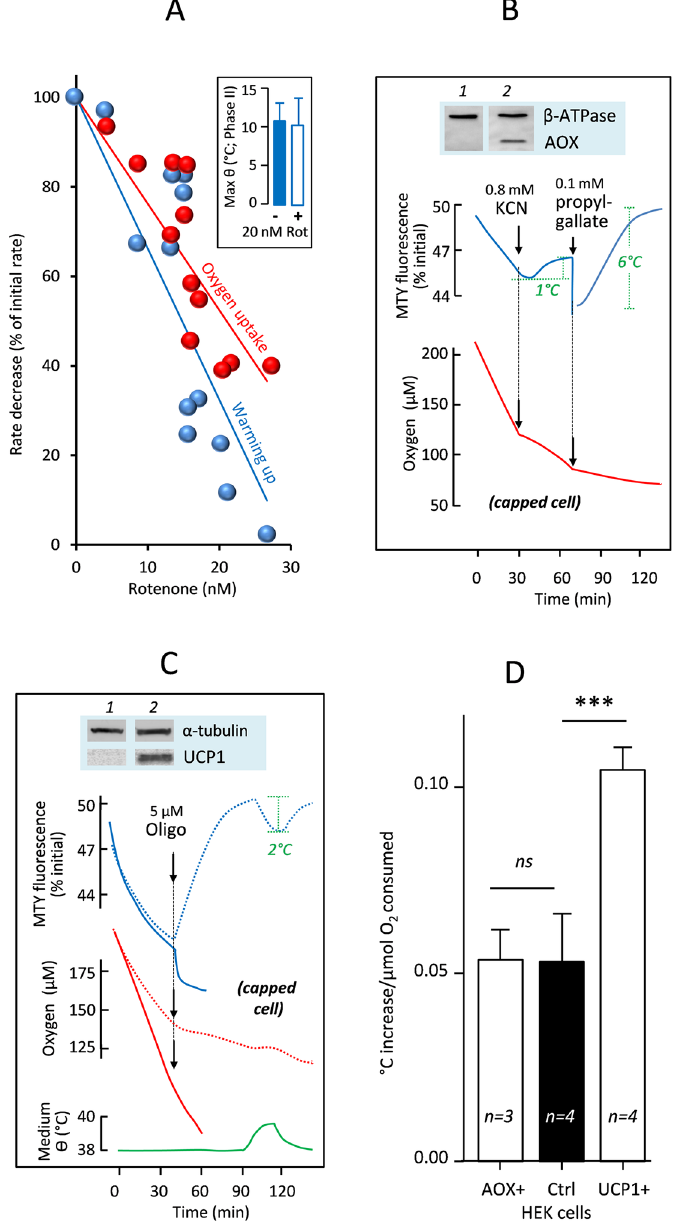
Fig 3. Effects on mitochondrial temperature of respiratory inhibitors, uncouplers, and expression of heterologous mitochondrial proteins. (A) Effect of variable rotenone addition to control HEK293 cells on the rates of oxygen uptake and fluorescence decrease of MTY. Rotenone was added at t = 4 min; rates calculated from 4–7 min and expressed as a percent of initial rate. Inset: maximal warming of HEK293 cell mitochondria in the absence or presence of 20 μM rotenone. (B, C) Changes in MTY fluorescence (blue lines), cell respiration (B, C) (red lines), and temperature of cell suspension medium (green line), with additions of inhibitors as shown (potassium cyanide, n- propyl gallate, and/or oligomycin), alongside western blots confirming expression of the indicated genes: Ciona intestinalis AOX (B), UCP1 (C), alongside loading controls, as indicated. Traces for control cells are shown by dotted lines. The abrupt change in fluorescence upon addition of n-propyl gallate is due to the absorbance of the chemical itself. Note that in all experiments in which MTY fluorescence was measured, the value reached at the end of phase I was in all cases significantly different from the starting value, whilst that in phase IV was not ( n = 4; (cid:3)(cid:3)(cid:3) ). (D) Computed from experiments using HEK293 cells endowed with AOX (AOX+), UCP1 (UCP1+) or control cells, initial increases of temperature (˚C) per μmol oxygen consumed were compared and statistically analyzed by one-way ANOVA with Bonferroni’s multiple comparison test ( n = 3–4; means ± SD). Graphic drawings, means, and